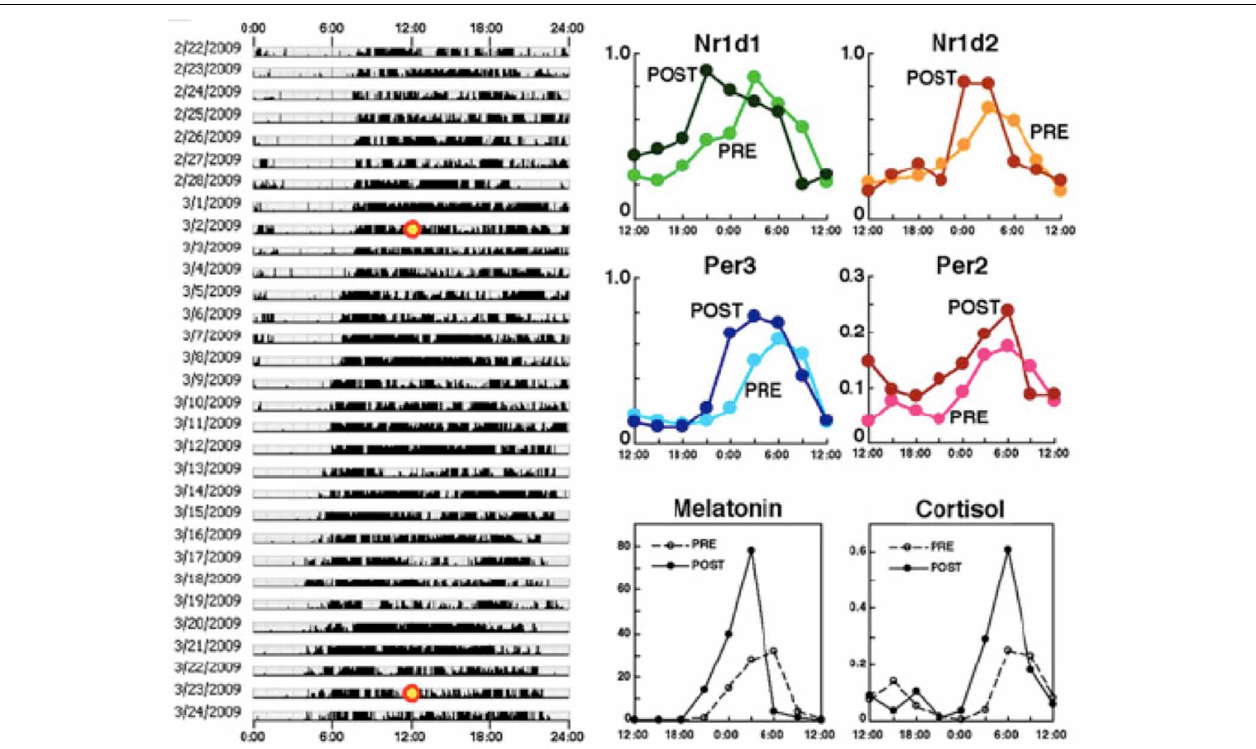
FIGURE 7 | A 3-week adaptation period is not enough to advance the phase of the molecular clock by 4h. Behavioral rhythms (left), rhythms in four clock genes from hair follicles (upper right) and melatonin and cortisol concentrations from saliva (lower right). Specimens were collected every 3h from the time points marked with a yellow circle (3/2/2009: PRE, 3/23/2009: